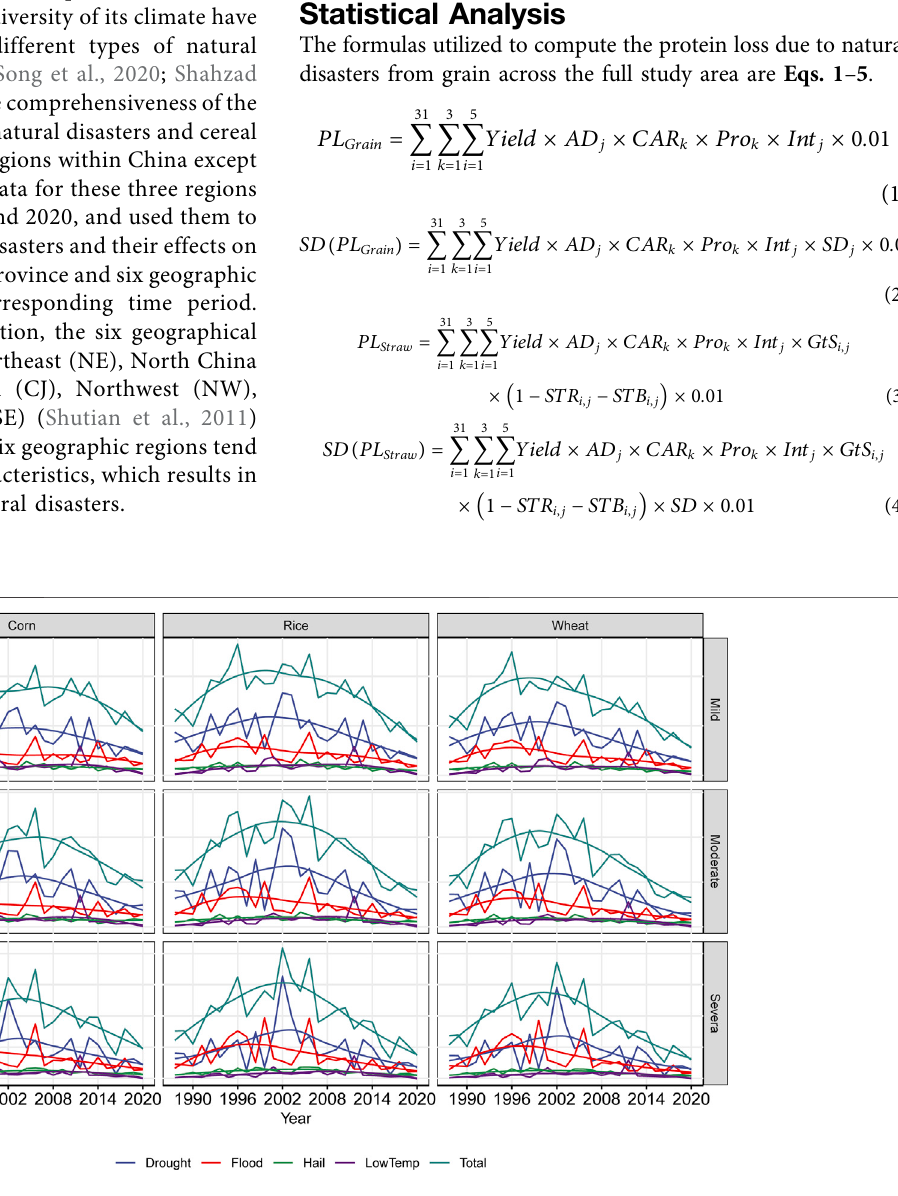
FIGURE2| Trendsintheratioofthenaturaldisaster-affectedareatothetotalcultivationareafordifferentdisasterintensitiesanddifferentcropsfrom1988to2020. The smooth lines in each panel represent loss trends.